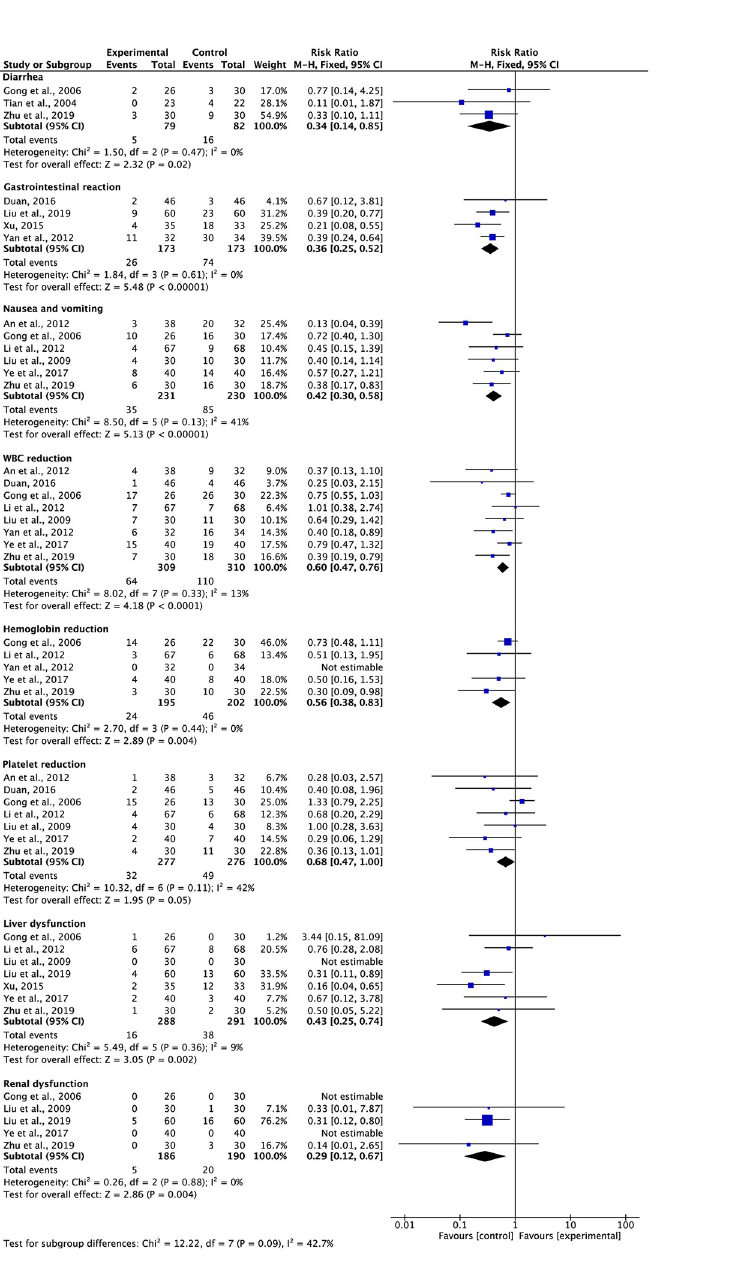
Fig 9. Meta-analysis results of